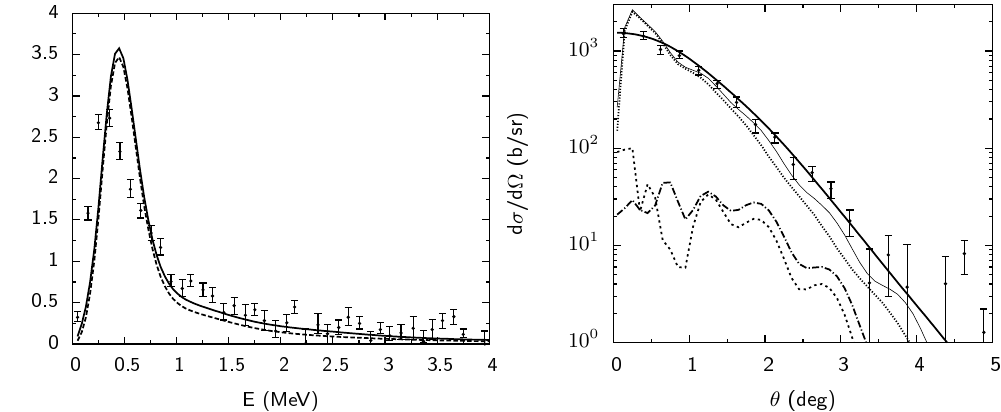
Figure 6: Cross sections for the breakup of 11 Li on Pb at 70 MeV / nucleon expressed as a function of (left) the 9 Li-n-n relative energy E after dissociation and (right) the 9 Li-n-n centre of mass. Coulomb-corrected eikonal calculations [ 28 ] are compared to the experimental data of Ref. [ 29 ] . Reprinted figure with permission from Ref. [ 28 ] . Copyright (2012) by the American Physical